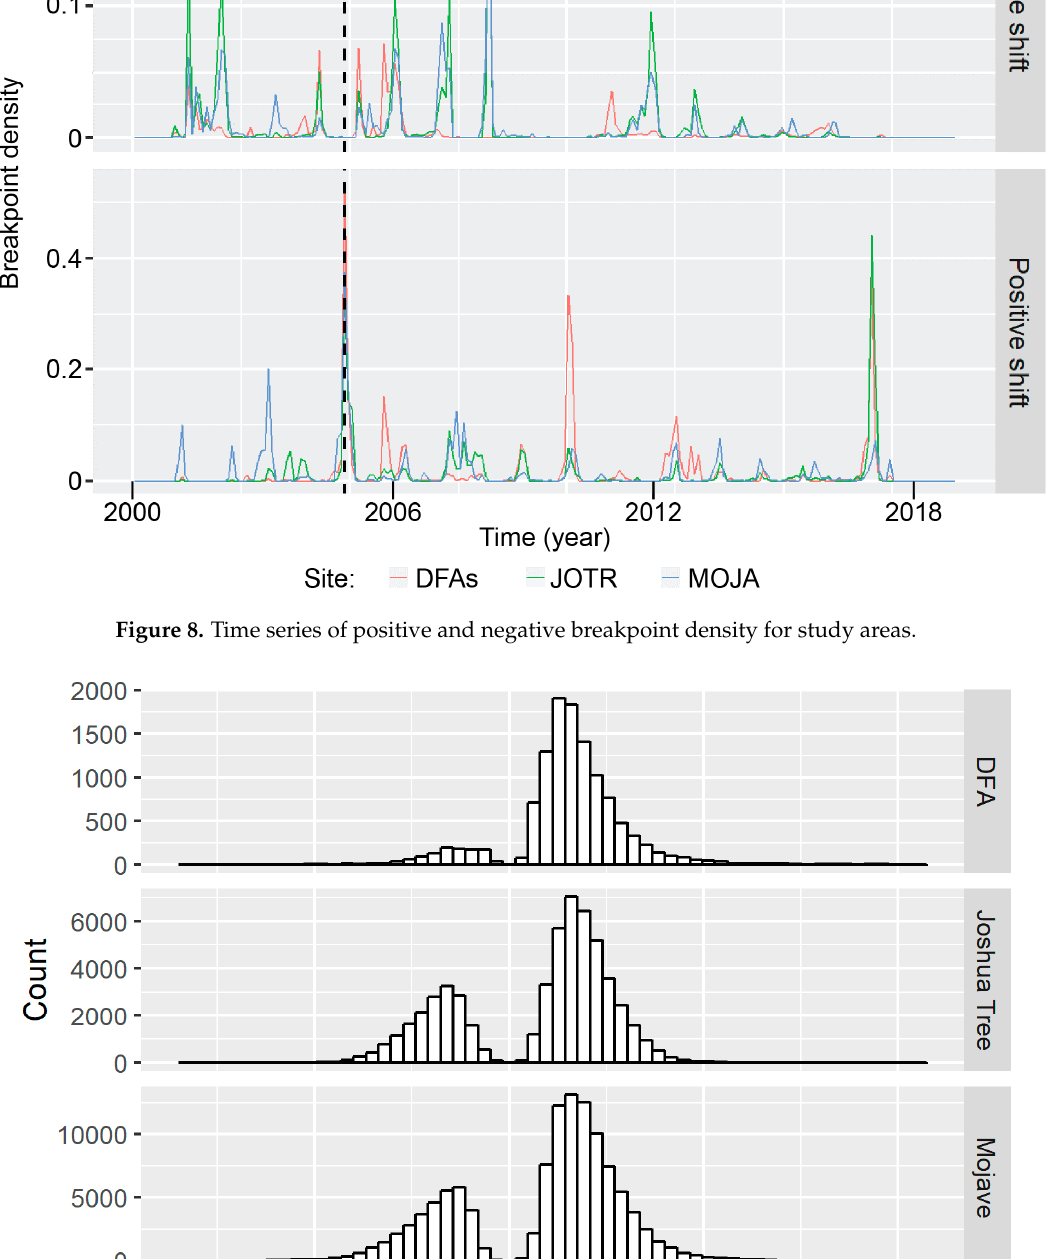
Figure 10. Histogram of positive breakpoint shifts by site.